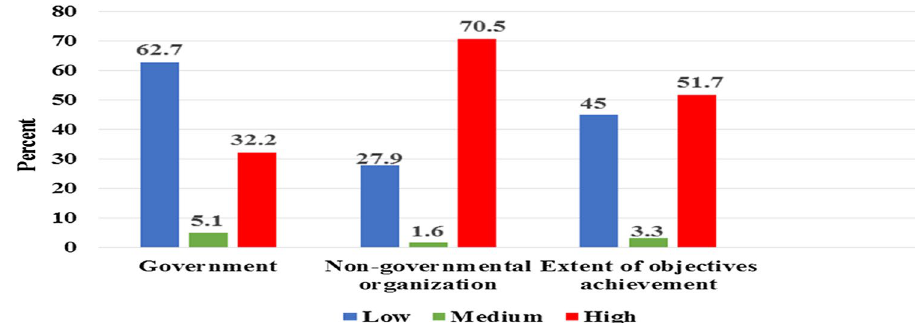
Fig. 2 Overall achievement of water projects’